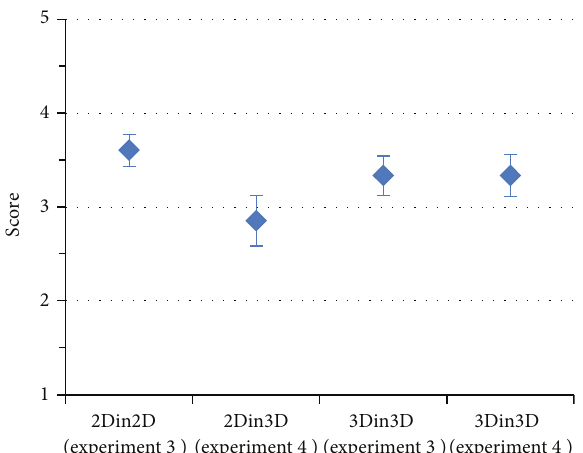
Figure 5: Comparison of the mean quality scores of experiments 3 and 4, in which a different viewing mode was used for the 2D content(i.e.,experiment3usedthe2Dmodeatfullspatialresolution and no glasses, while experiment 4 used the 3D mode at half spatial resolution and with glasses).